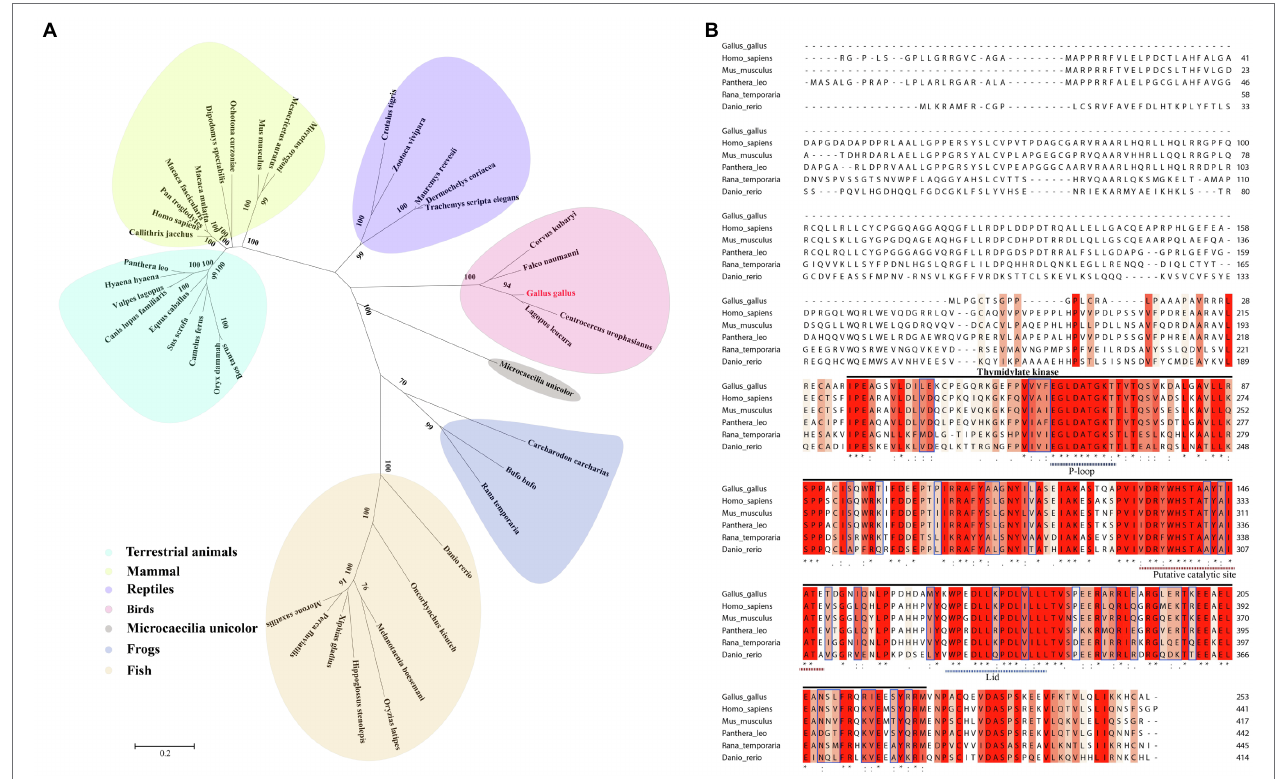
FIGURE 2 | Bioinformatics analysis of chicken CMPK2. (A) Phylogenetic tree of CMPK2 using an amino acid sequence alignment among different species. Animals belonging to the same species are marked with the same color. (B) Alignment of Gallus gallus (XP_040523494.1), Homo sapiens (AAI41803.1), Mus musculus (AAH57565.1), Panthera leo (XP_042789682.1), Rana temporaria (XP_040204584.1), and Danio rerio (XP_699055.5) CMPK2 amino acid sequences using the Multiple Sequence Alignment tools on the EMBL-EBI website. Shading indicates sequence conservation, with deeper red indicating a higher degree of conservation. Conserved thymidylate kinase domain sequences were analyzed. At the bottom of the aligned sequences, “*” indicates fully conserved residues; “:” indicates identical or similar residues; “.” indicates relatively conserved residues. The P-loop, putative catalytic site, and lid motif are indicated by “…...”